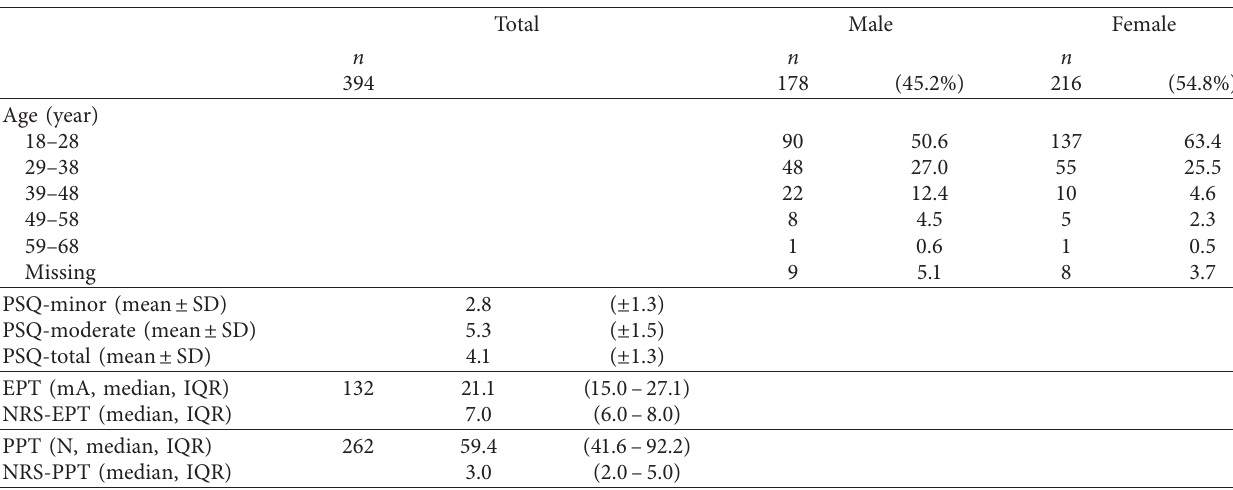
Table 2: Characteristics of the